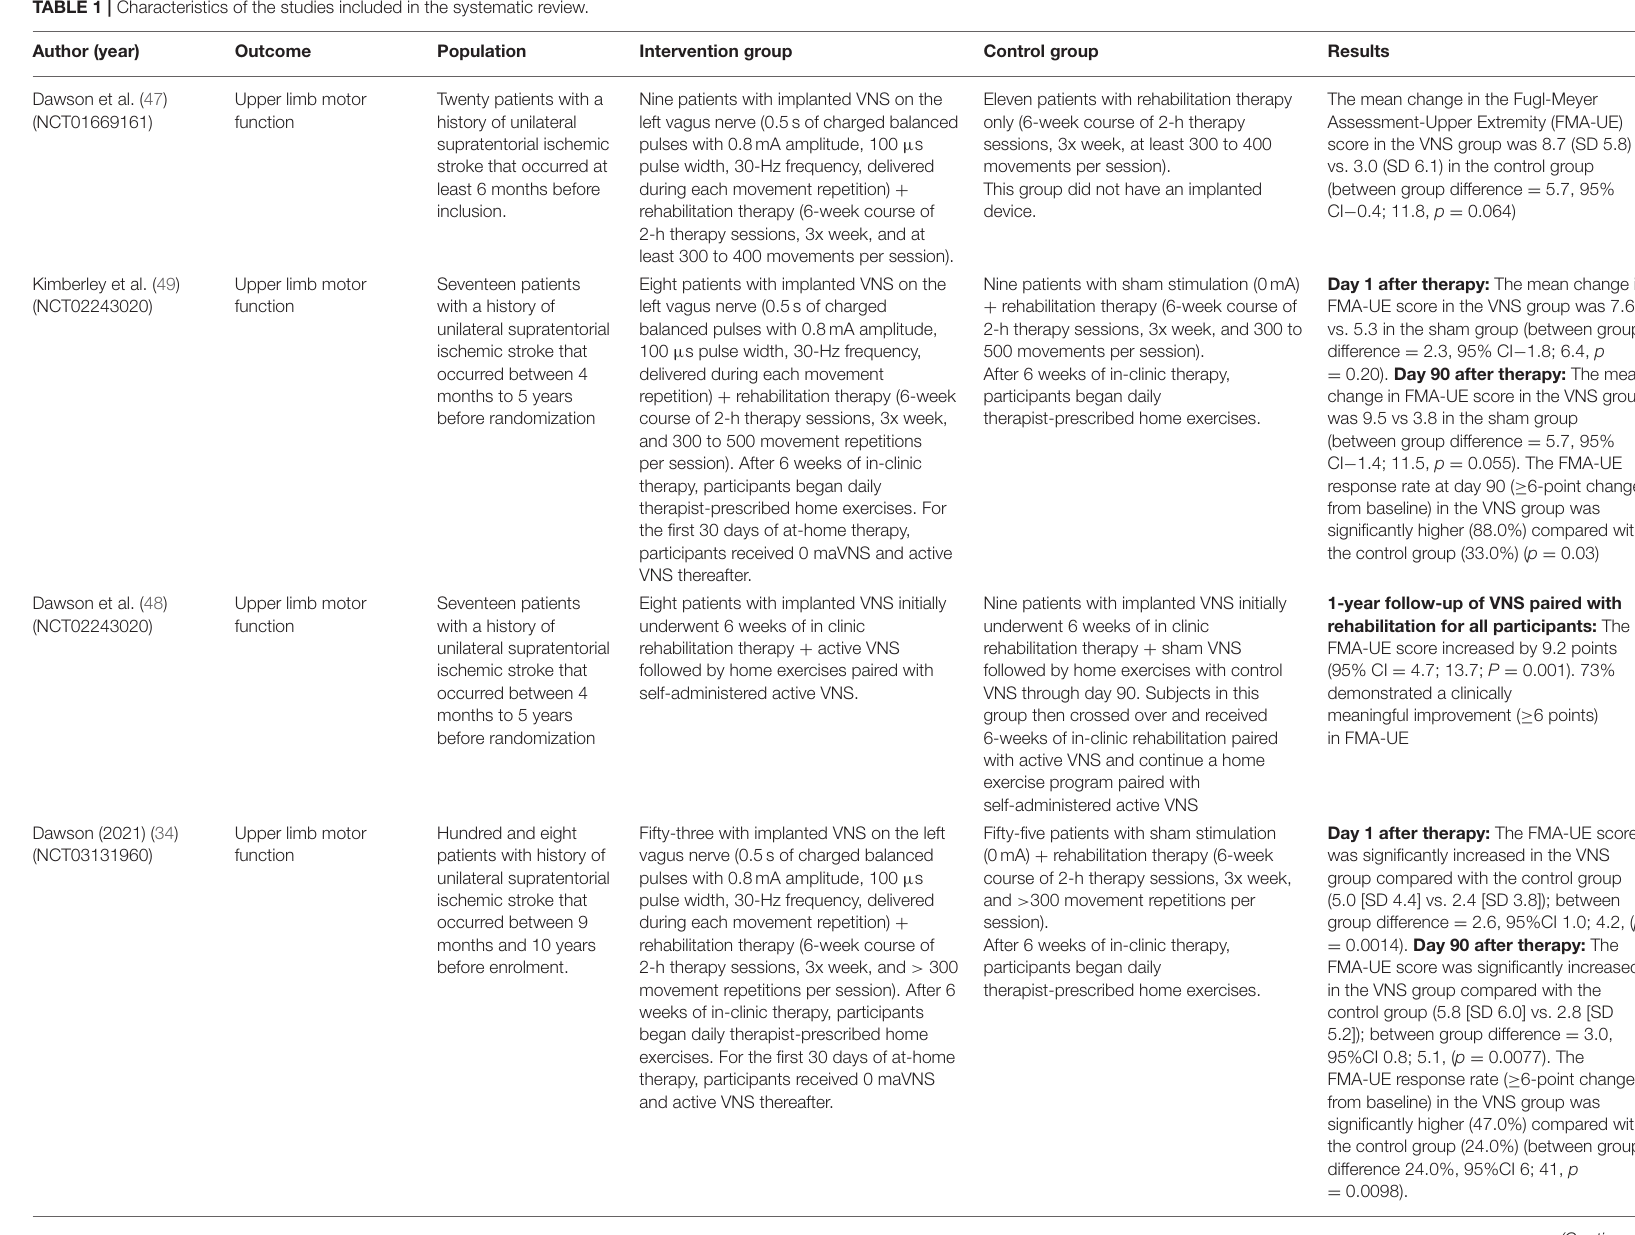
TABLE 1 | Characteristics of the studies included in the systematic